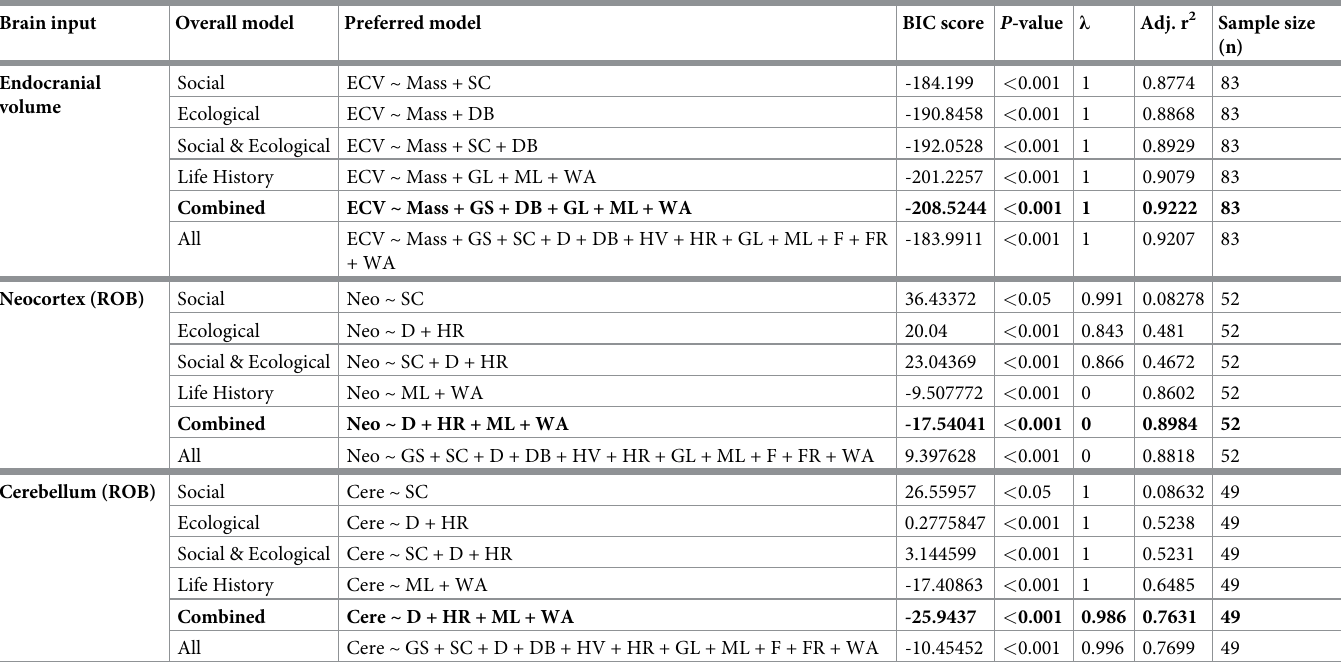
Table 1. Phylogenetic generalised least-squares (PGLS) regression analyses examining the effects of social, ecological and life-history variables � on primate whole and regional brain volumes. Preferred models represent the ‘ best fit ’ model (with the lowest BIC score) of the overall model category (i.e., social or ecological). The com- bined models represent the ‘ best fit ’ model after running all combinations of the previous ‘ best fit ’ models (models one to four). Boldness indicates the model(s) with the lowest BIC score across all models (dBIC < 2).